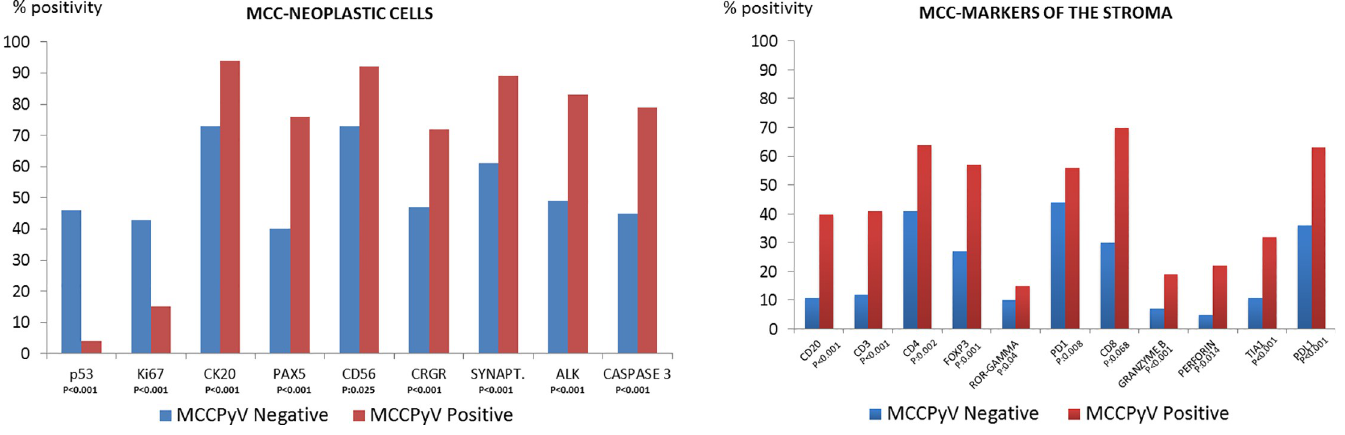
Fig 1. MCC-neoplastic